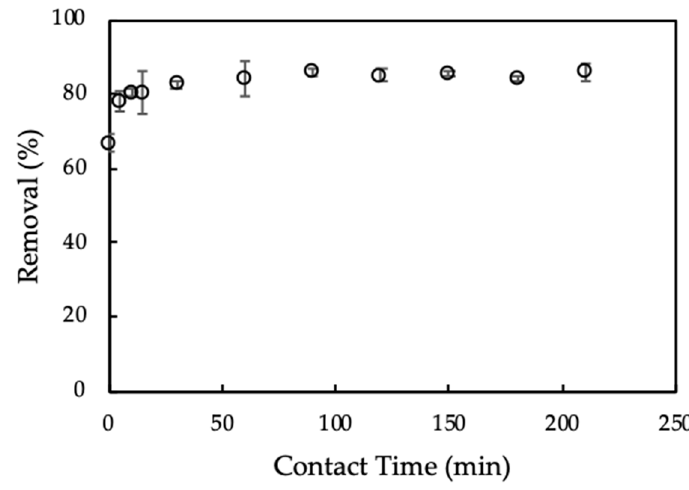
Figure 8. E ff ect of adsorption time on removal of ciprofloxacin (CFX) using protein-modified nanosilica (ProMNS). C i (CFX) = 20 mg / L, pH 7.0, adsorbent dosage 10 mg / mL, 1 mM KCl). Error bars show